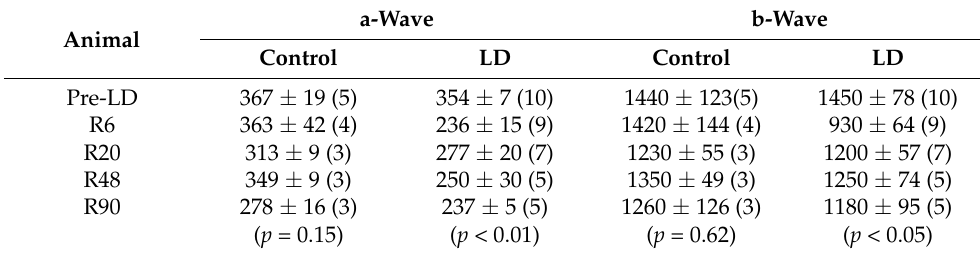
Table 1. Comparison of dark-adapted ERG responses ( µ V) for control and light-damaged animals; Mean ± SEM ( n ). p values are comparison of Pre-LD vs. R90 within each column ( n = 3 WT, n = 5 LD).